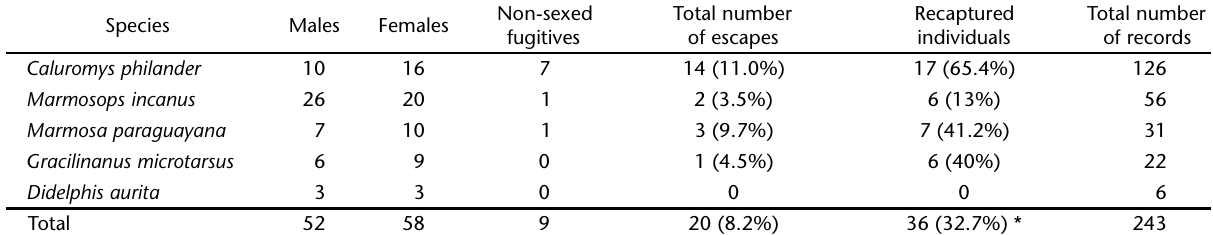
Table I. Species and individuals recorded in artificial nests at Garrafão, Serra dos Órgãos National Park, Rio de Janeiro, Brazil. Non-sexed Species Males Females